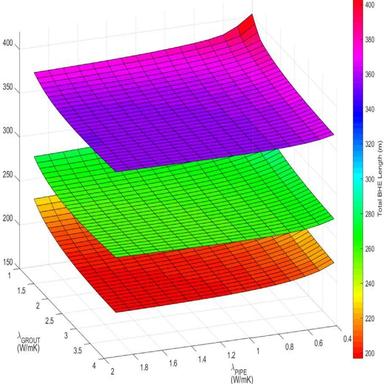
Graphic showing the simultaneous effect of varying the lPIPE and lGROUT in the Rb of a designed system for a house in a mild region with high (bottom), medium (middle) and low (upper) thermal conductivity of the ground.